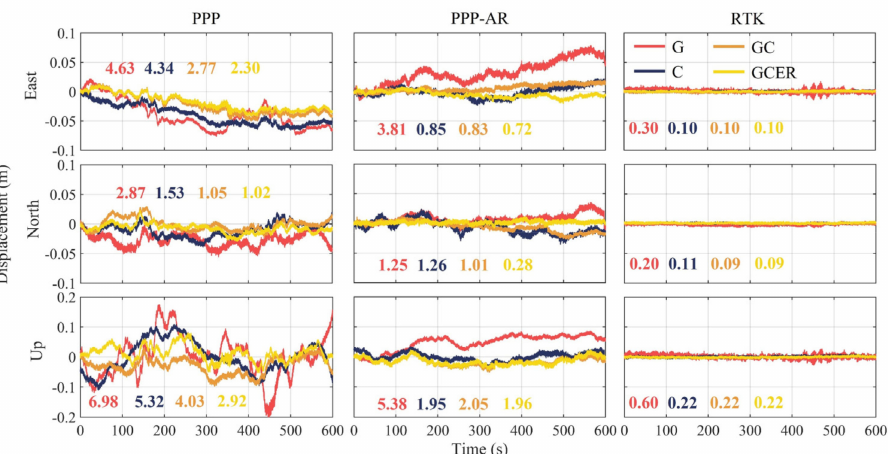
Figure 3. 100-Hz 3D displacement time series from G, C, GC, and GCER observations, respectively, and PPP, PPP-AR, and RTK techniques. The upper, middle, and lower panels represent displacements in the East, North, and Up directions, respectively, while the left, middle, and right columns represent results from PPP, PPP-AR, and RTK, respectively. The standard deviation (in cm) of each time series is given in the corresponding